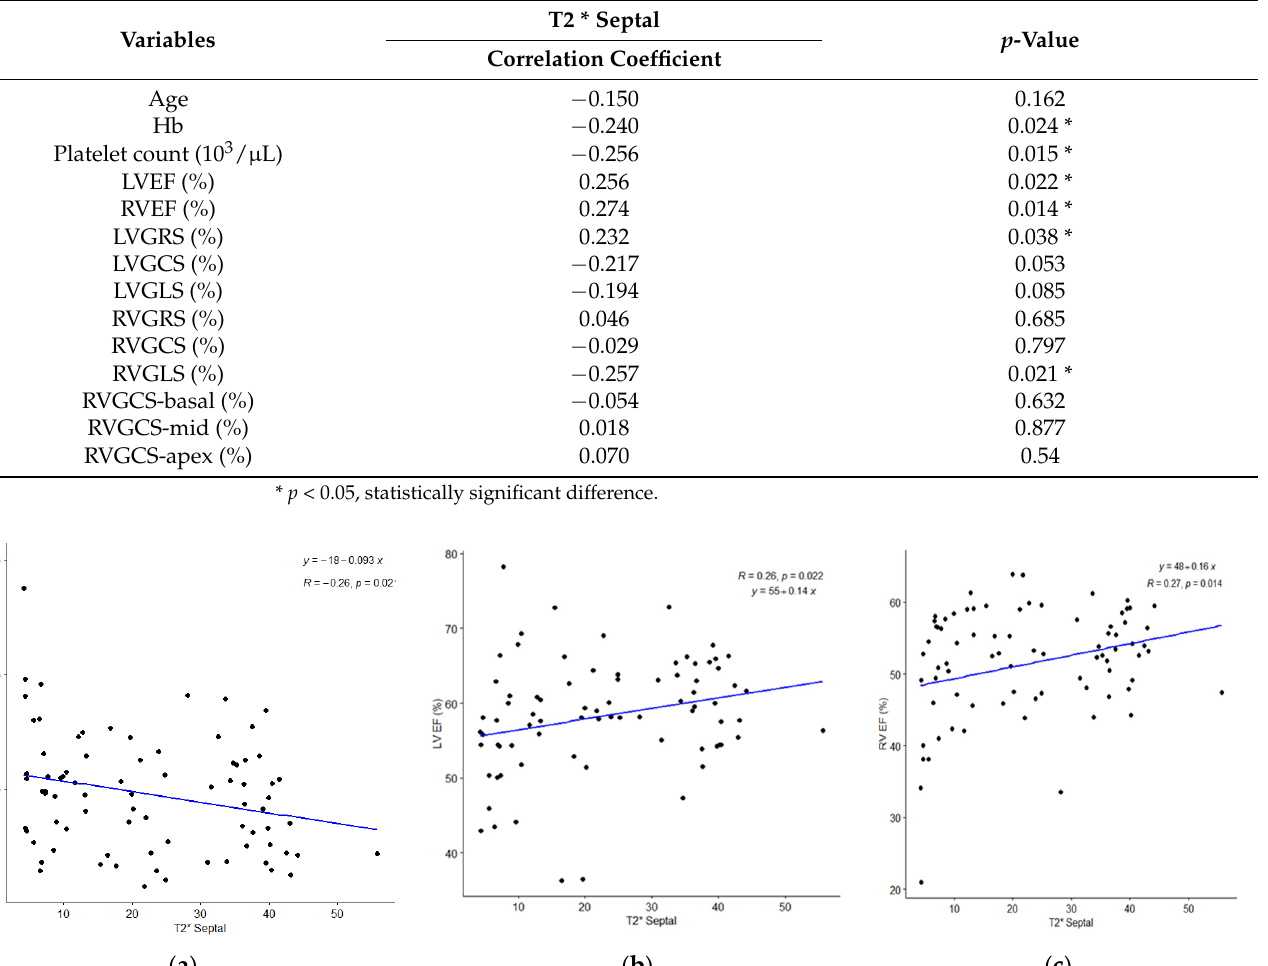
Table 2. Correlation between T2* Septal measurements and Age, Hb, platelet count, and RV/LV strain values.